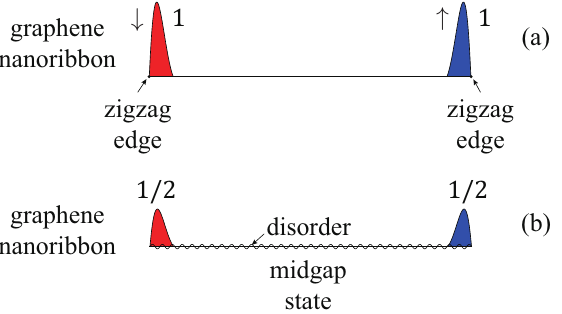
Figure 10. ( a ) In a clean and gapful ZGNR, the zigzag edges couple antiferromagnetically and no fractional boundary charge exists on them. An edge state of this system displays an integer boundary charge of one. The shaded areas in the figure indicate the probability densities of the edge states. Note that the chirality differs among the zigzag edges. ( b ) In a disordered ZGNR the antiferromagnetic coupling is partly weakened and a midgap state ( E 0) with a given spin value can display fractional ≈ end charges of e /2. Note that this state is localized along the zigzag edges, in contrast to the AGNR case shown in Figure 8b. The wavy line indicates a disorder